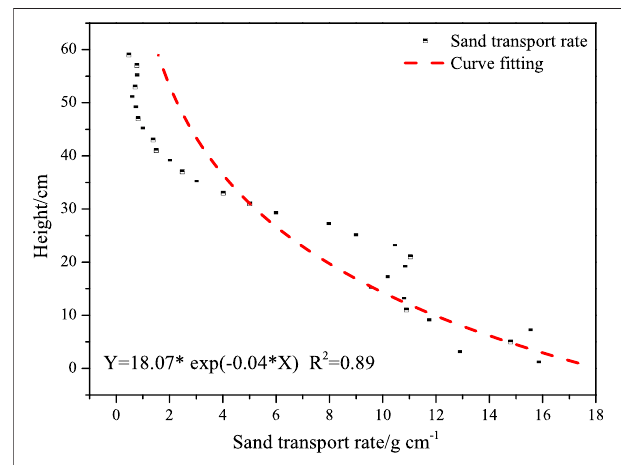
FIGURE 8 | Relation between the sand transport rate and height at the observation